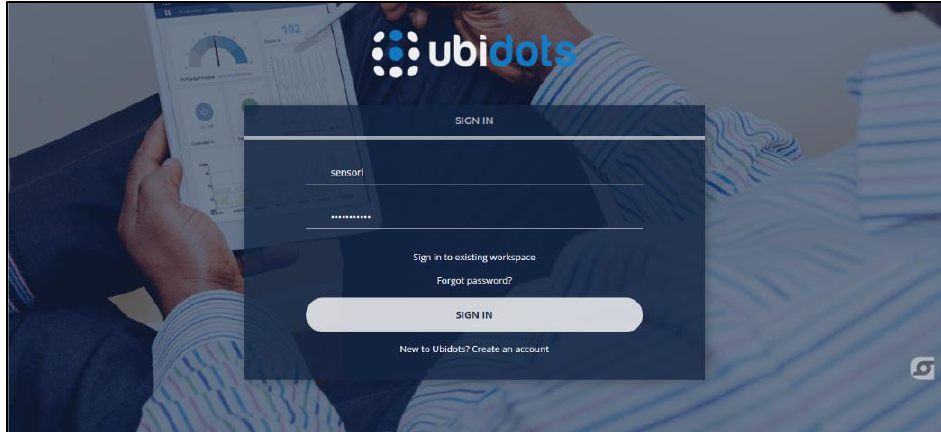
Figure 7. Ubidots home page.